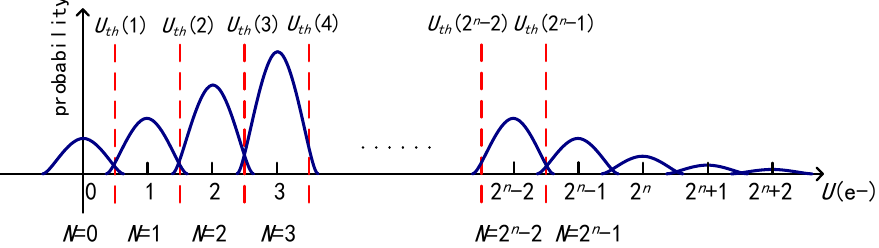
Figure 4. The probability distribution of the output signal and the quantization of the multi-bit QIS.